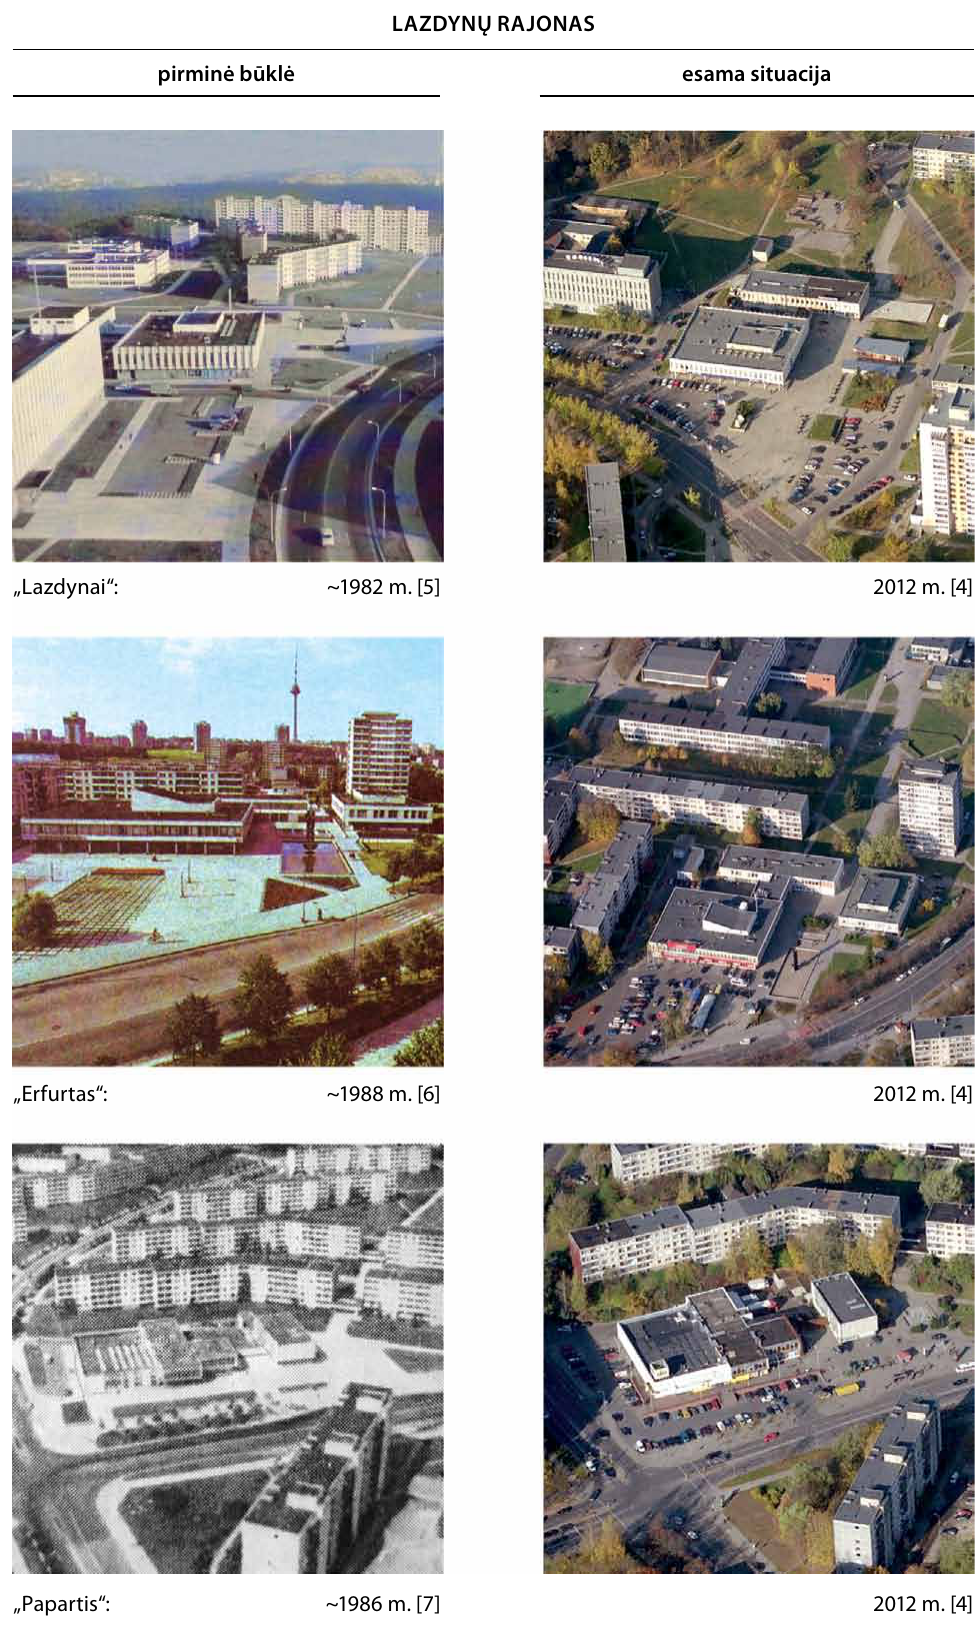
Fig. 5. Chronological Transformations of Public Spaces in lazdynai residential